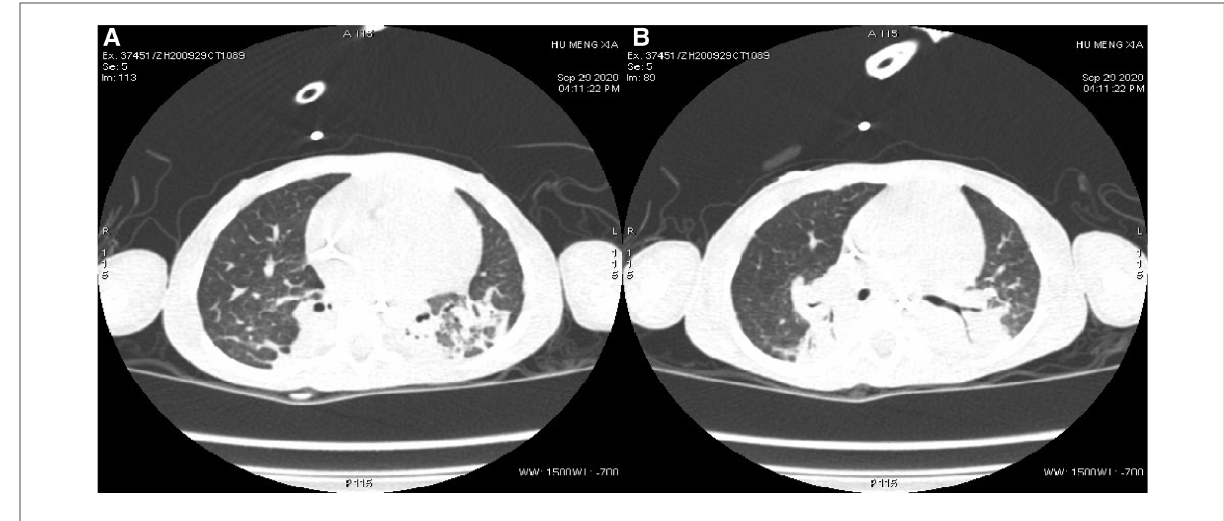
FIGURE 1 Changes in pulmonary imaging. ( A ) Consolidation of the bilateral lower lobe; ( B ) atelectasis of the posterior basal segment of the right lung.